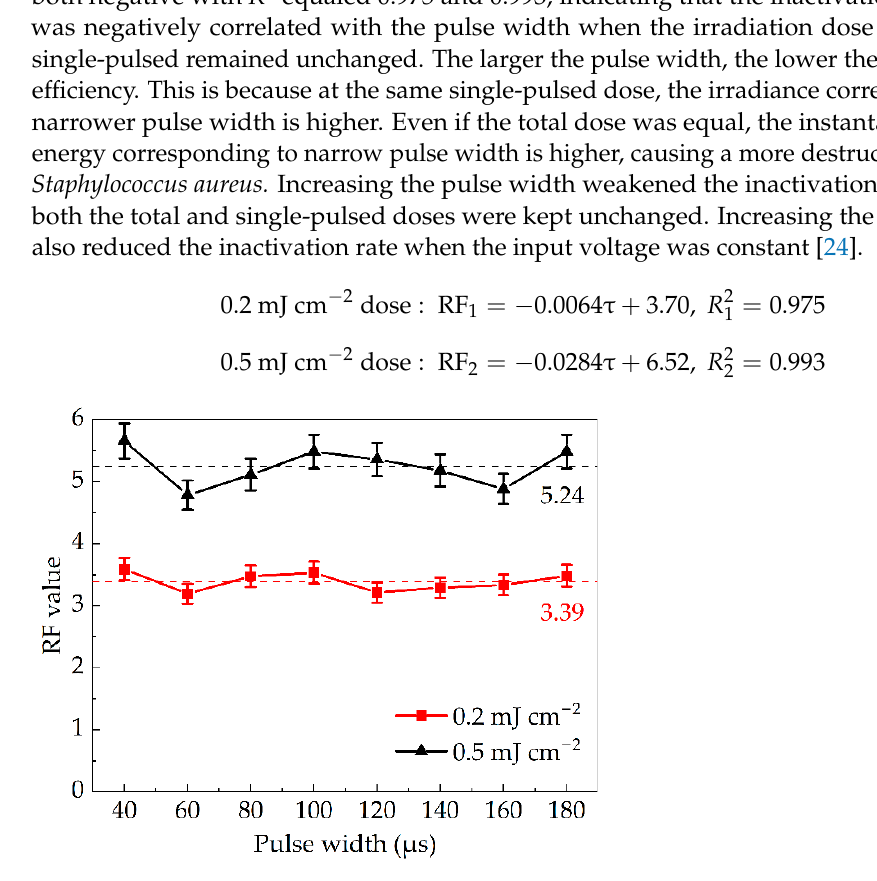
Figure 4. Dependence of RF value on pulse width.